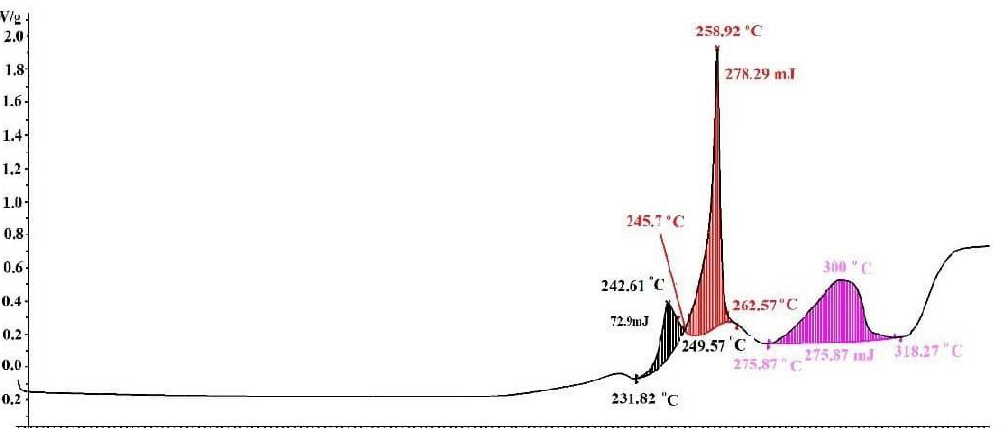
Figure 6. DSC curve of a silver maleate.